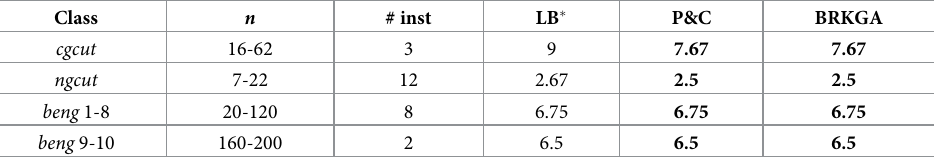
Table 13. Comparison of the solutions obtained by the different approaches for the cgcut , ngcut , and beng instances when 90˚ rotation of the items is allowed.